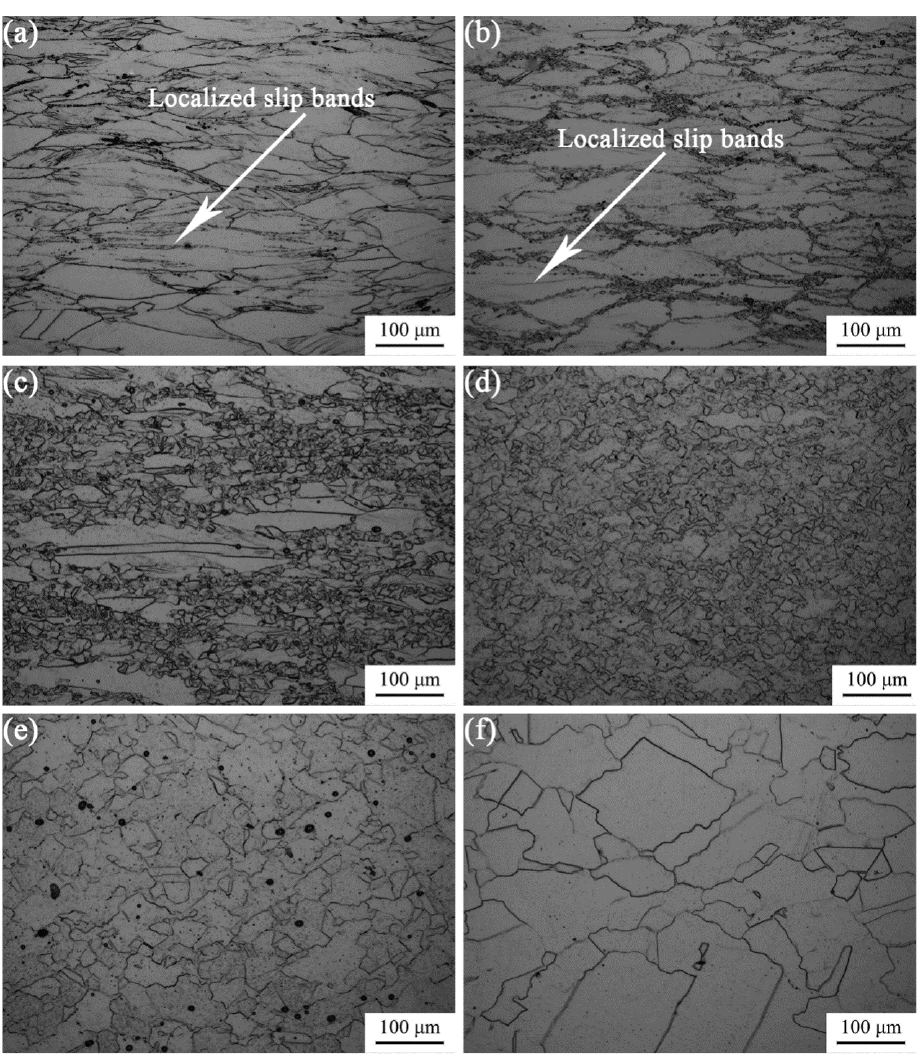
Figure 12. The microstructures of Fe-30Mn-0.11C steel at different deformation conditions: ( a ) 800 °C, 1 s − 1 ; ( b ) 900 °C, 1 s − 1 ; ( c ) 900 °C, 0.01 s − 1 ; ( d ) 1000 °C, 0.01 s − 1 ; ( e ) 1100 °C, 0.01 s − 1 and ( f ) 1200 °C, 0.01 s − 1 .